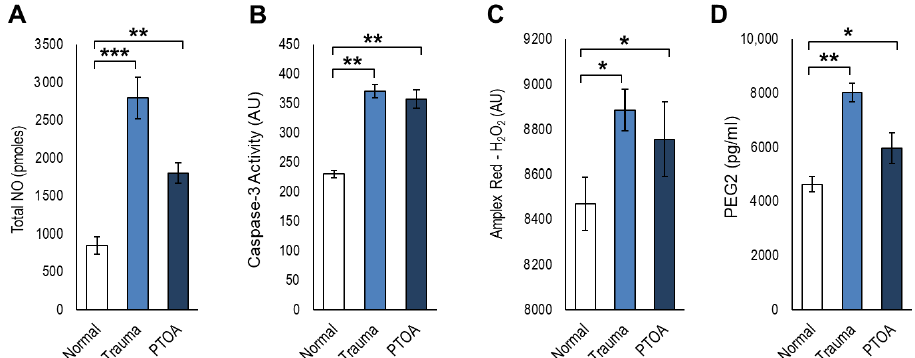
Figure 4. Serum biochemical analyses of Trauma and PTOA to control unloaded normal knee joint. Level of ( A ) total NO, ( B ) caspase-3 activity, ( C ) Amplex Red H 2 O 2 , and ( D ) PEG2 in sera. Data are represented as mean ± SD. * p < 0.05, ** p < 0.01, and *** p < 0.001. ( n = 6 per group).